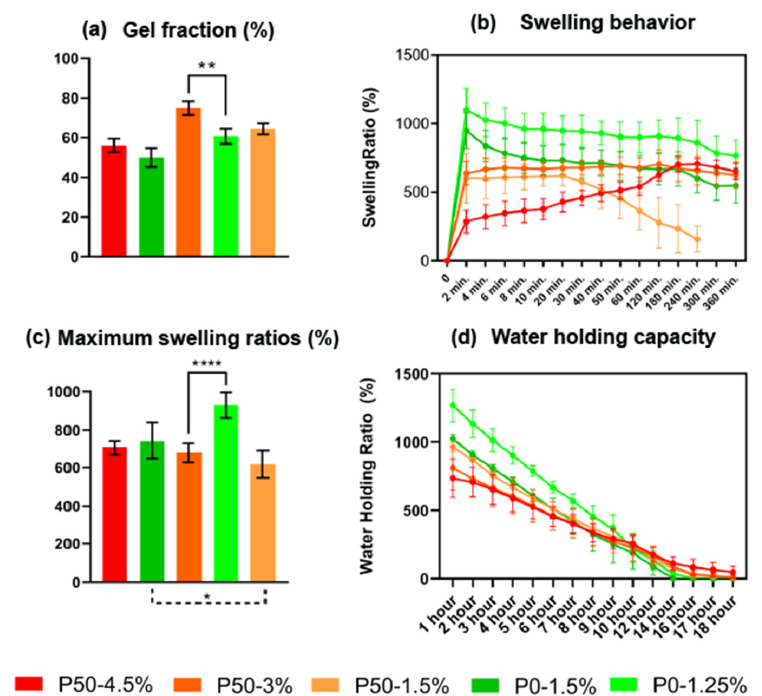
Figure 6. ( a ) Gel fraction; ( b ) swelling behavior; ( c ) maximum swelling ratios; ( d ) water holding capacity of pectin-based hydrogels, n = 5, * p < 0.05, ** p < 0.01, **** p < 0.0001.